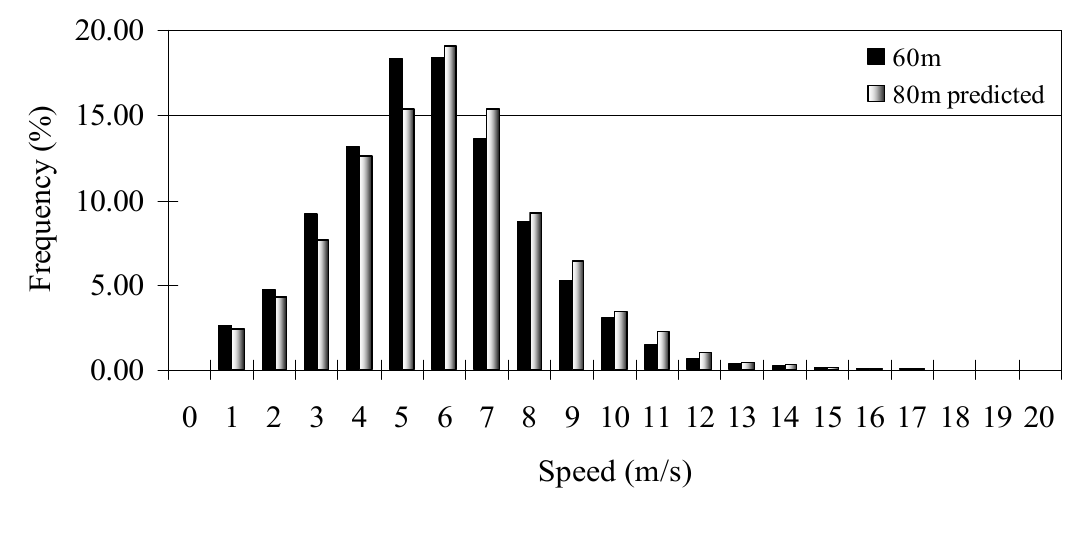
Figure 1. A histogram of wind speeds at North Farm, Principia College for April 2008–March